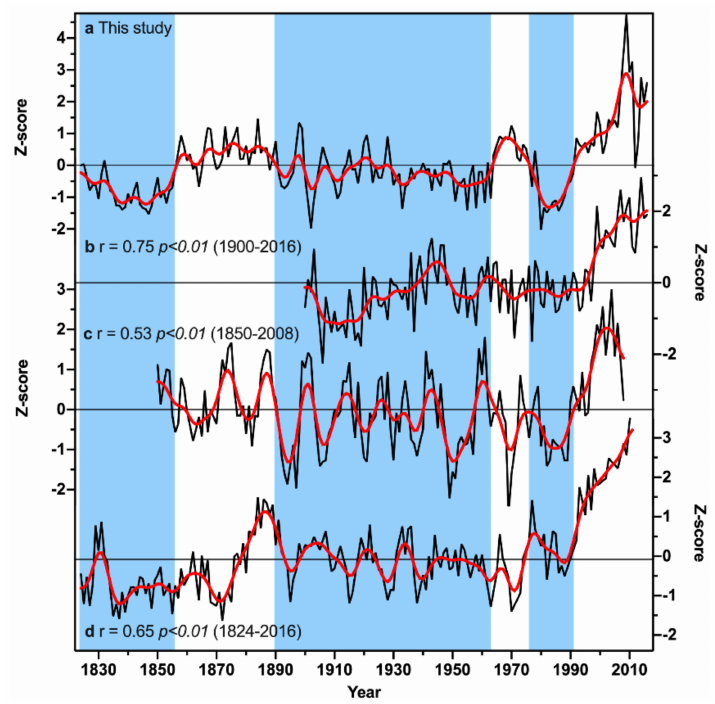
Figure 8. Comparison of our pMar-pOct mean temperature reconstruction with the temperature records from other studies. ( a ) the pMar-pOct mean temperature reconstruction in this study; ( b ) the NCDC gridded GHCN v4.0.1 pMar-pOct temperature anomalies over the region of 20 ◦ –40 ◦ N and 100 ◦ –120 ◦ E [51]; ( c ) the phenological and natural evidence based growing season temperature reconstruction in south-central China [63]; ( d ) the tree-ring based February-May temperature re- construction from the Shennongjia area in central China [64]. All series have been standardized for direct comparison. The red curve in each panel denotes a 11-year lowpass FFT filter. Vertical shading denotes cold periods in our reconstruction. The correlation coefficients were calculated between our reconstruction and the other three temperature series over their respective common